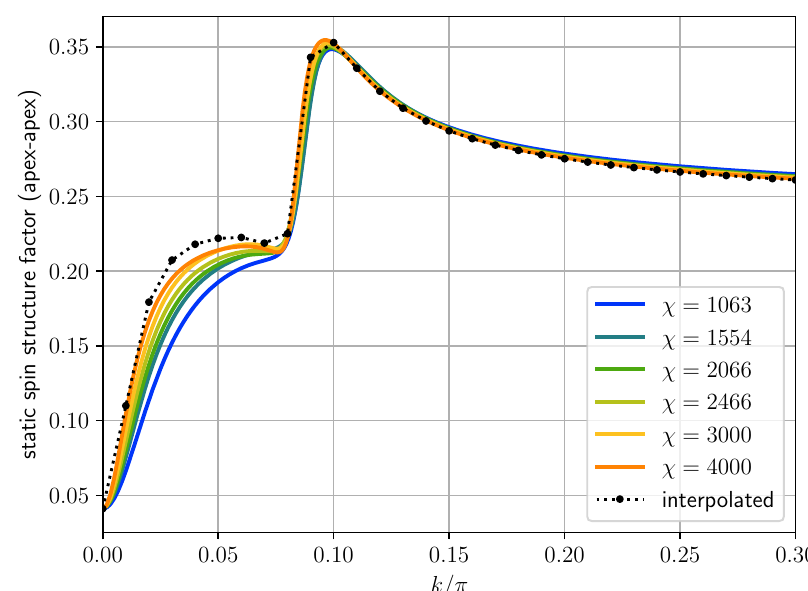
Figure 14: The static spin structure factor of Fig. 9 for J = − 1, J ′ = 1 and different bond dimensions χ with the U(1) spin symmetry exploited in the VUMPS algorithm. The result is linearly extrapolated in χ − 1 at the selected black points.